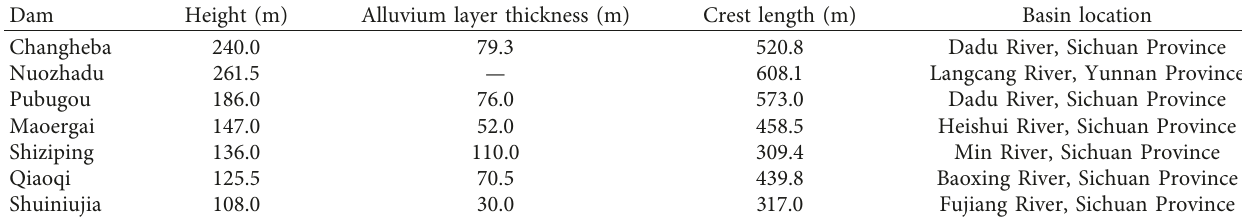
Table 1: High core wall rockfill dams with heights exceeding 100 m in southwestern